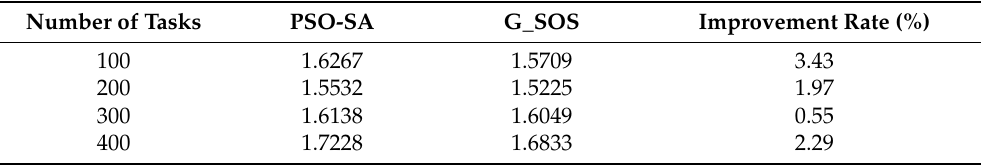
Table 11. Comparison of the Degree of Imbalance between PSO-SA and G_SOS for a uniformly distributed